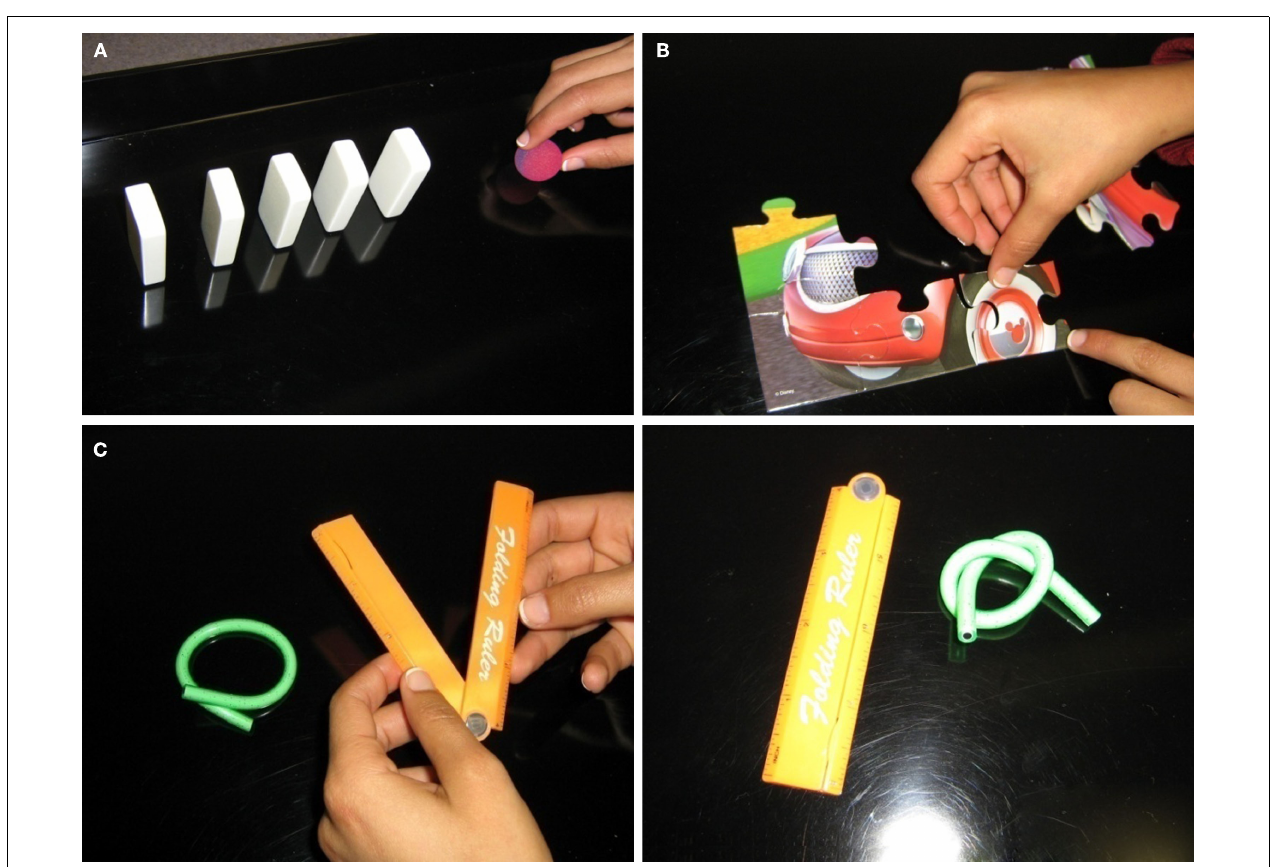
FIGURE 1 | (A) Example of a Causal action. (B) Example of a One-Event action. (C) Example of aTwo-Event